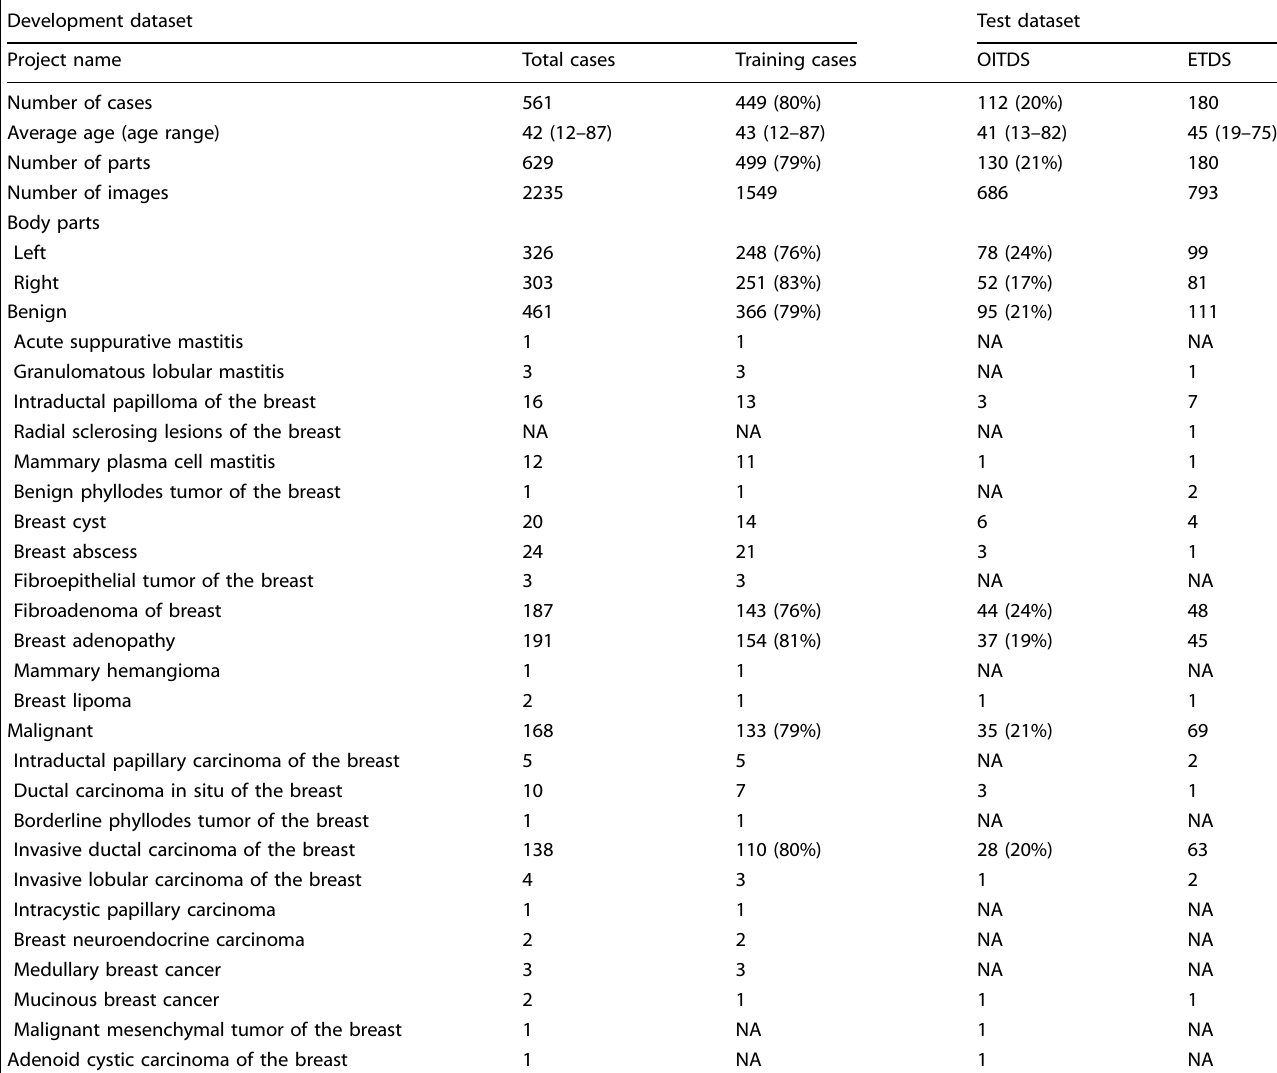
Table 1. Baseline characteristics of